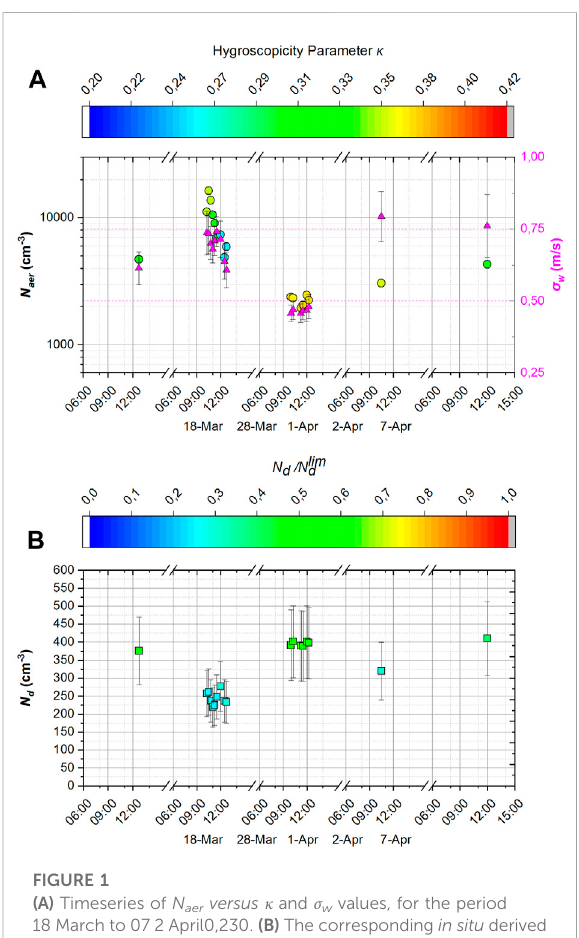
Figure 2A of Morales and Nenes (2010)) with an uncertainty 0.02, which we apply to our calculations. Given the above considerations, the characteristic vertical velocity w* used for calculating droplet formation (and used to estimate in situ N d ) is given by